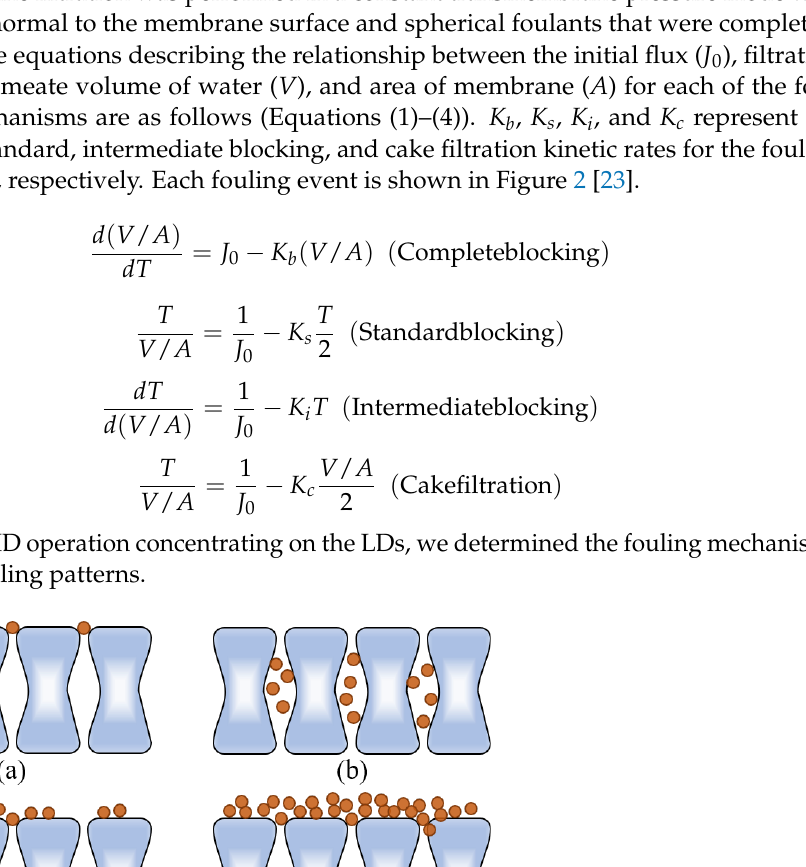
Figure 1. Schematic diagram of DCMD regenerating the LD.